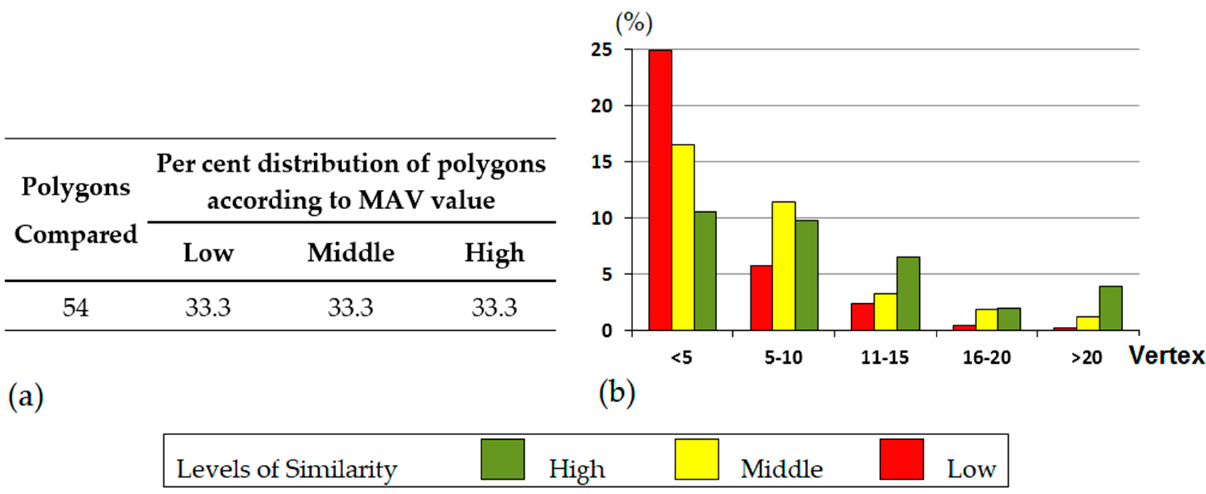
Figure 7. ( a ) Distribution of polygons according to the MAV computed by the GA, ( b ) percentage distribution of matched polygons for each level of MAV grouped by number of vertices.